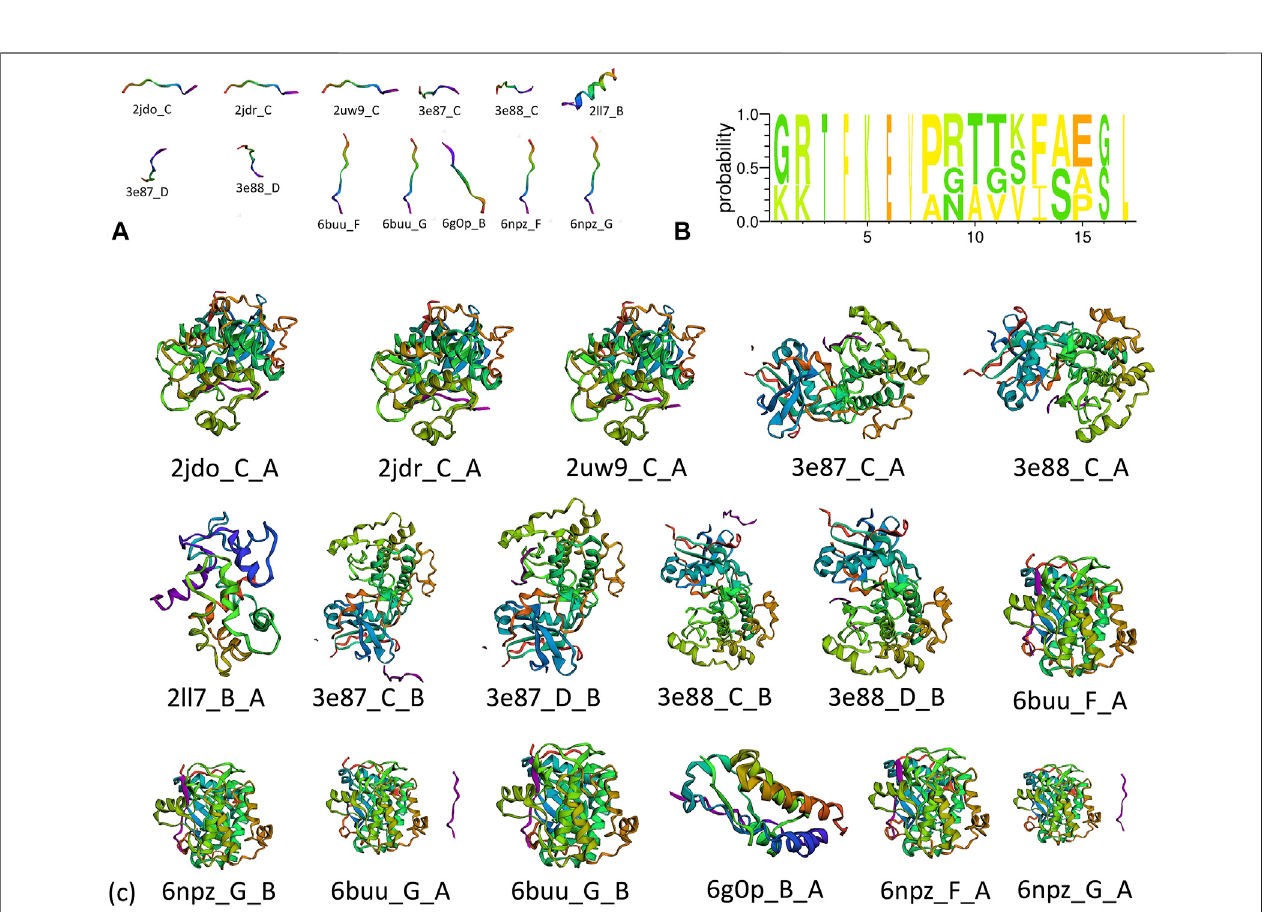
FIGURE 3 | (A) Structure of clustered peptides, (B) sequence alignment of clustered peptides, and (c) structure of fi ltered peptide – protein complexes.